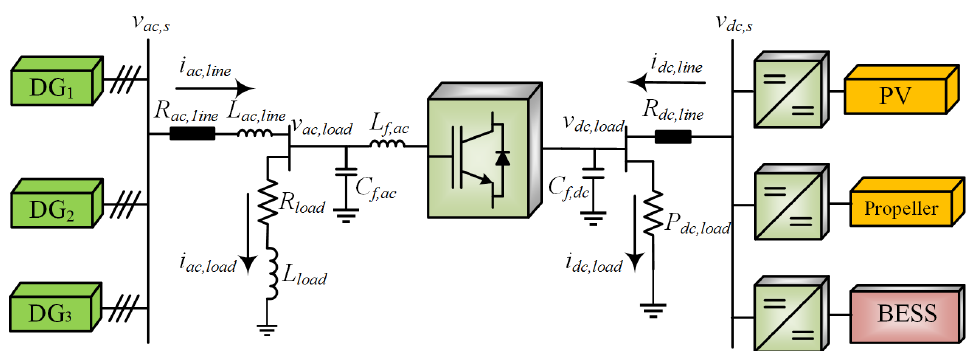
Figure 2. Single line diagram of hybrid shipboard